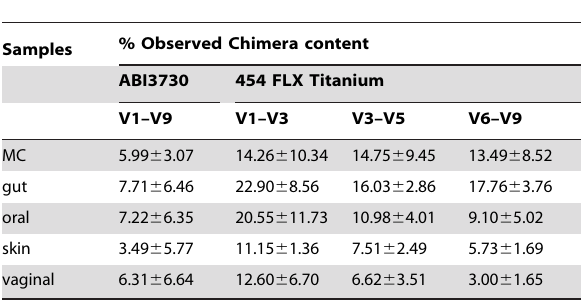
Table 1. Chimera rates in 16S data